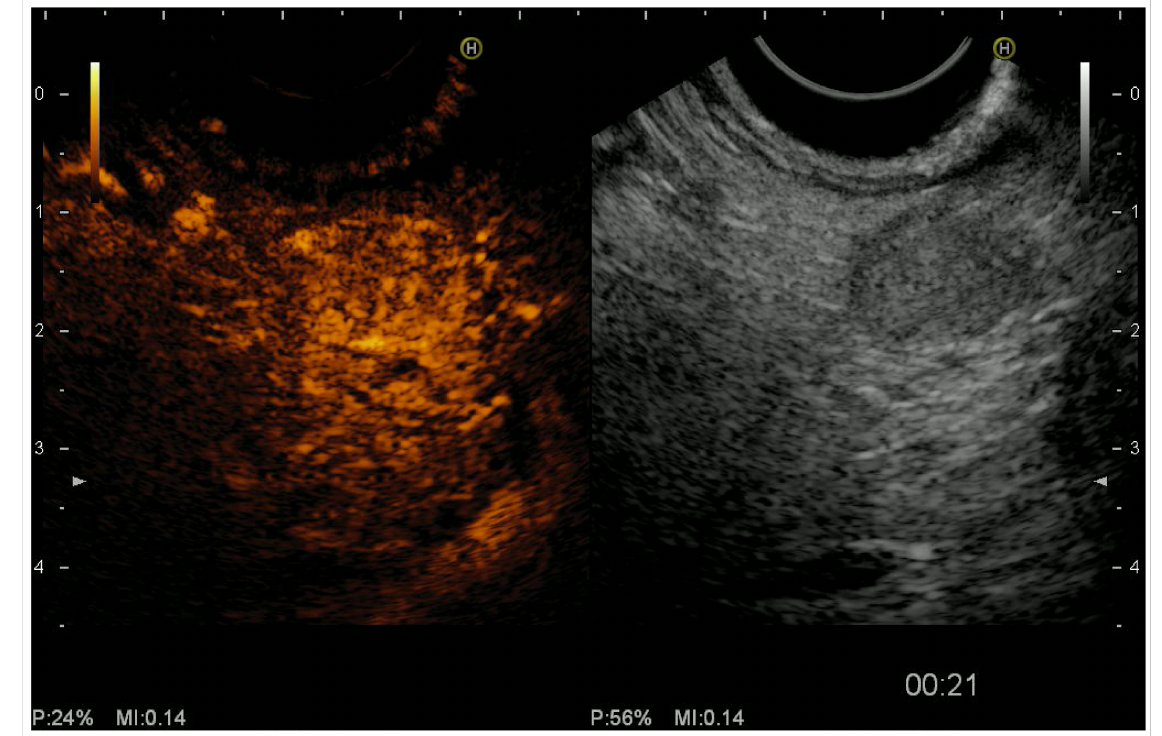
Figure 3. Endoscopic ultrasound (EUS) revealed a 10 mm hypoechoic lesion of the pancreas ( right panel ). Contrast- enhanced EUS showed typical homogeneous hyperenhancement of the lesion during the arterial phase in comparison to the surrounding pancreatic parenchyma ( left panel ) after intravenous injection of contrast agent (Sonovue™, Bracco Imaging, Milan, Italy). P, power; MI, mechanical